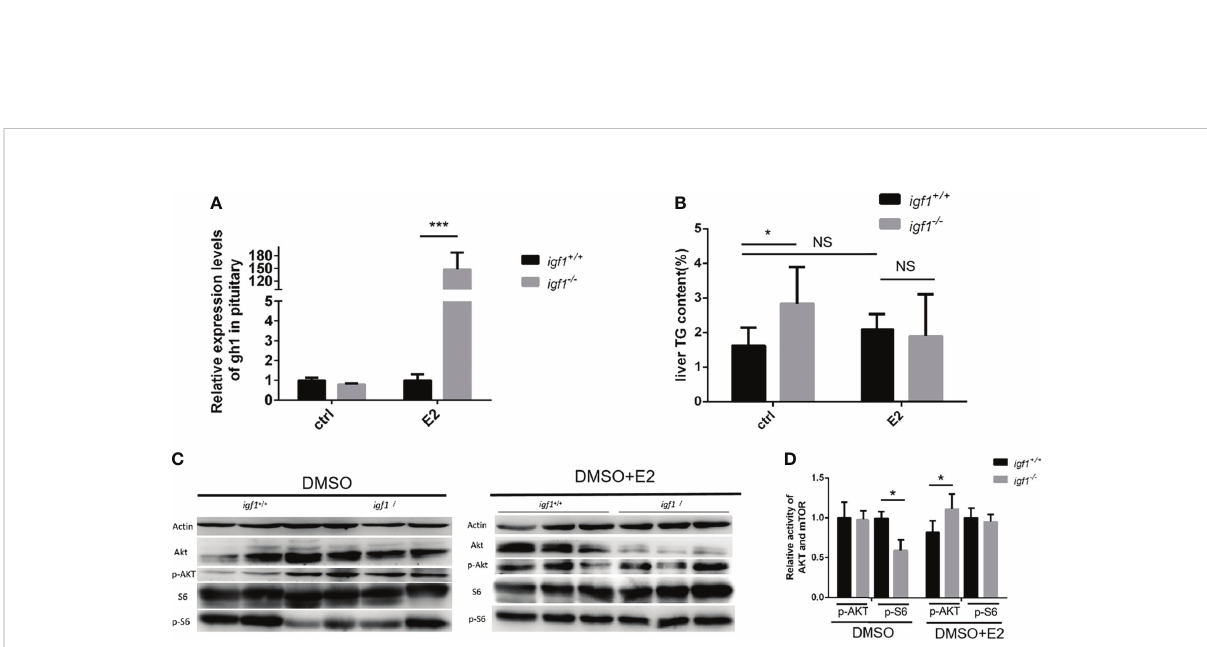
FIGURE 8 E2 rescue the hepatic steatosis and the AKT-mTOR signaling activity in liver. (A, B) Relative expression of gh1 gene in pitutary (A) of igf1 - de fi cient and wild type treated in E2(100 m g/L). Triglyceride composition in liver (B) of igf1-de fi cient and wild type treated in E2(100 m g/L). An independent experiment was carried out in which the control group zebra fi sh was treated with 5% DMSO in fi sh water. (C, D) Western blot analysis of hepatic AKT-mTOR signal activity in male zebra fi sh. Four animals were sampled for each experiment and three biological repeats were carried out and statistical analysis was performed using a t test (p<0.001, n=3). *p < 0.05, ***P <